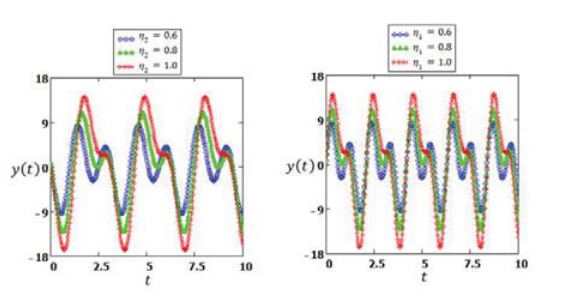
Figure 5: Comparative Analysis displacement for varying fractional parameters of Atangana-Baleanu and Caputo-Fabrizio fractional differential operators with parametric values τ 0 = 0.2, F = 0.3, t = 2 s , ω =